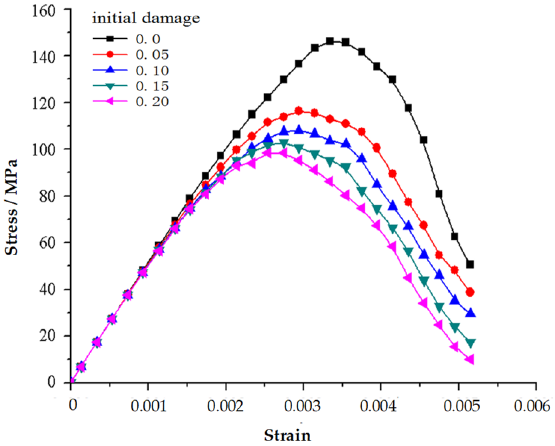
Figure 5. Relationship between initial damage and stress ‐ strain curve at strain rate 100 s − 1 .